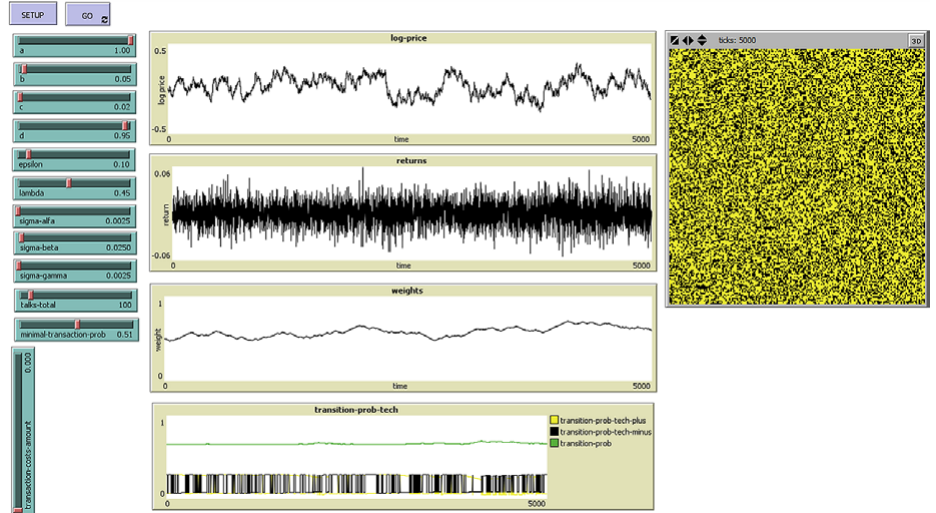
Fig. 1. Results of the simulation process ( source :